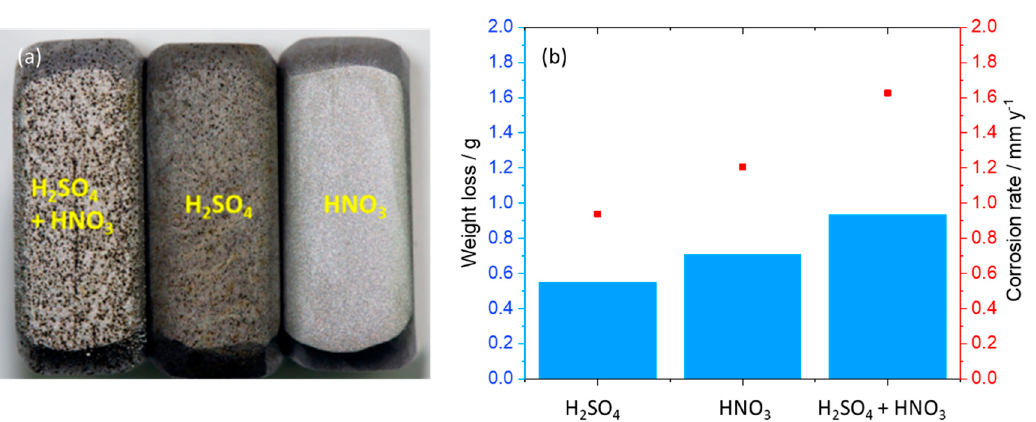
Figure 8. (a) Surface of corroded coupons (on the sides) exposed to the mixture, H 2 SO 4 and HNO 3 condensates, relatively (from left to right) after cyclic voltammetry tests and ( b ) corrosion rate calculated from weight loss after one-month exposure test. The initial weight of each coupon was around 13 g.